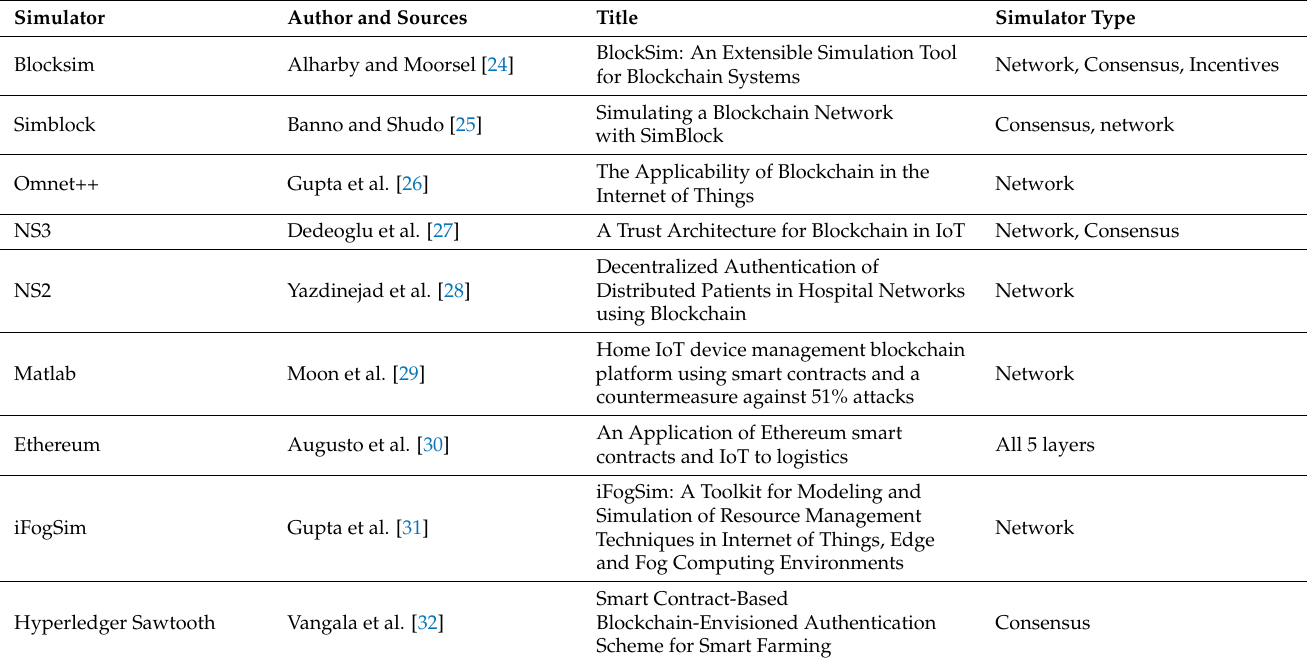
Table 1. A representation of simulator article and simulator